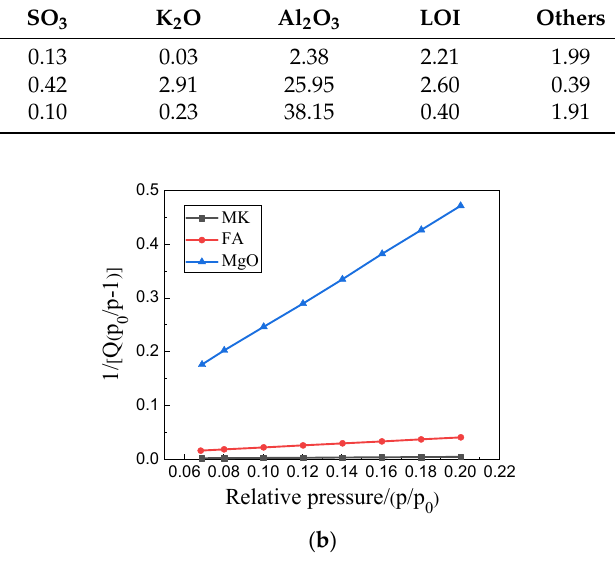
Figure 1. ( a ) Physical adsorption curves; ( b ) specific surface areas of MgO, FA, and MK.